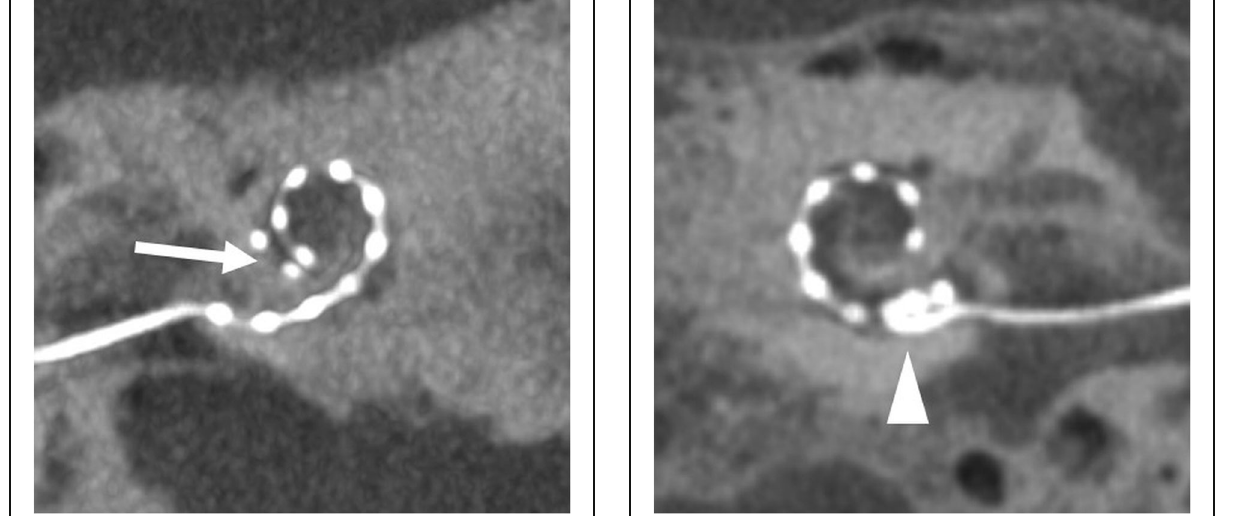
Fig. 30 A 55-year-old female patient, with basal fold-over. CBCT paraaxial maximum intensity projection image shows fold-over of the basal part of the electrode within the cochlea